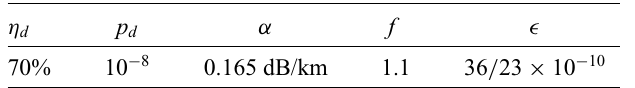
TABLE II. Simulation parameters. Here η d and p d are the detector efficiency and dark count rate, respectively; α is the attenuation coefficient of the fiber; f denotes the error correc- tion efficiency; and (cid:17) is the failure probability considered in the error verification and finite data analysis.